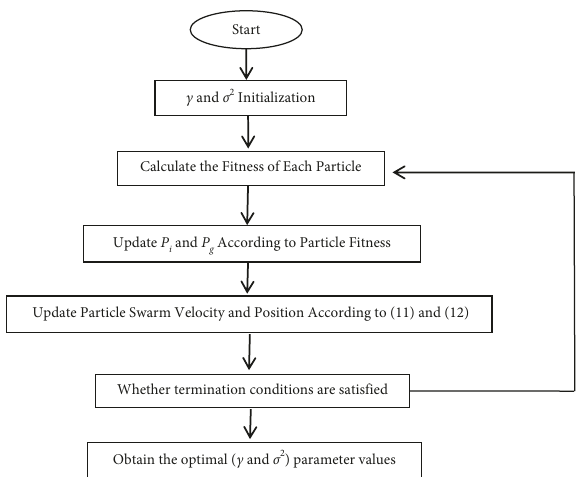
Figure 1: Logic flow of LS-SVM optimized by